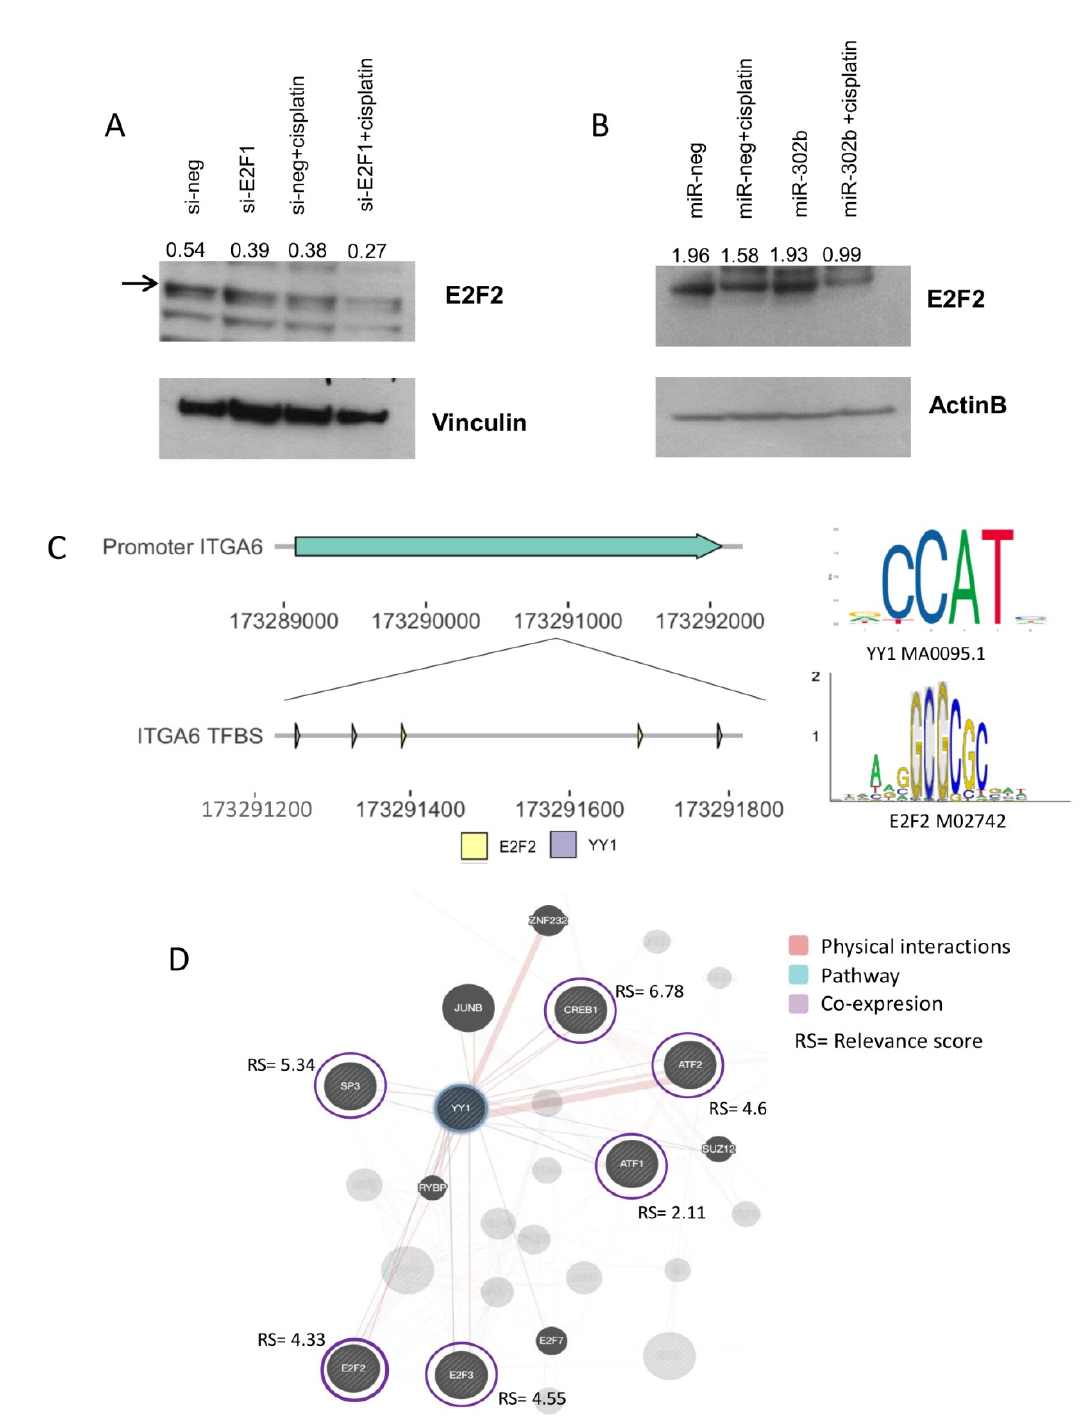
Figure 5. E2F2 protein expression under miR-302b plus cisplatin treatment in an in vitro model and in silico E2F2 correlation with the YY1 / ITGA6 biological axis. E2F2 expression after ( A ) si-E2F1 knockdown and ( B ) miR-302b transfection in MDA-MB-231 cells treated or not with cisplatin, respectively. Vinculin and β -actin were used as housekeeping controls. Data are representative of three independent experiments performed at least in triplicate. ( C ) Schematic representation of robust neighbor binding sites of YY1 and E2F2 on the ITGA6 promoter. Right panel shows TFs motif from the JASPAR database used in the analysis. ( D ) Correlation network of YY1 and human TFs predicted to physical interact with YY1.